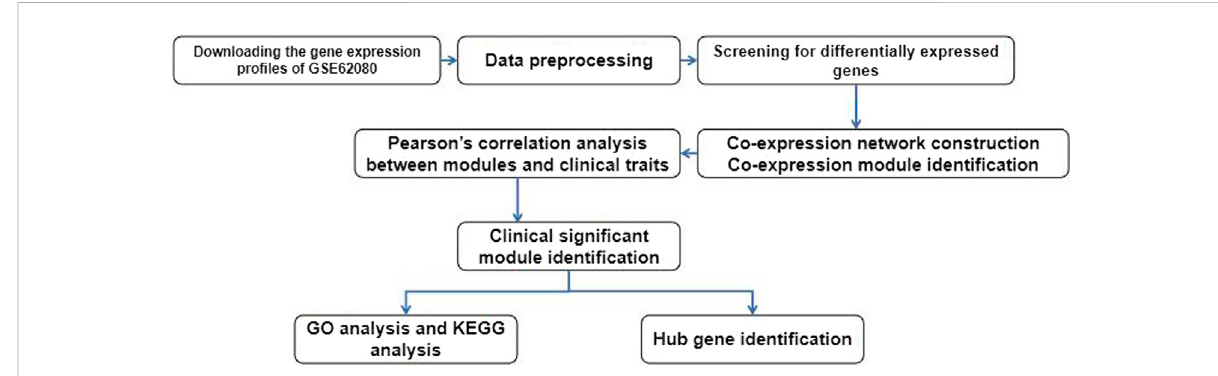
FIGURE 1 Flowchart of data preparation, processing, analysis, and validation.